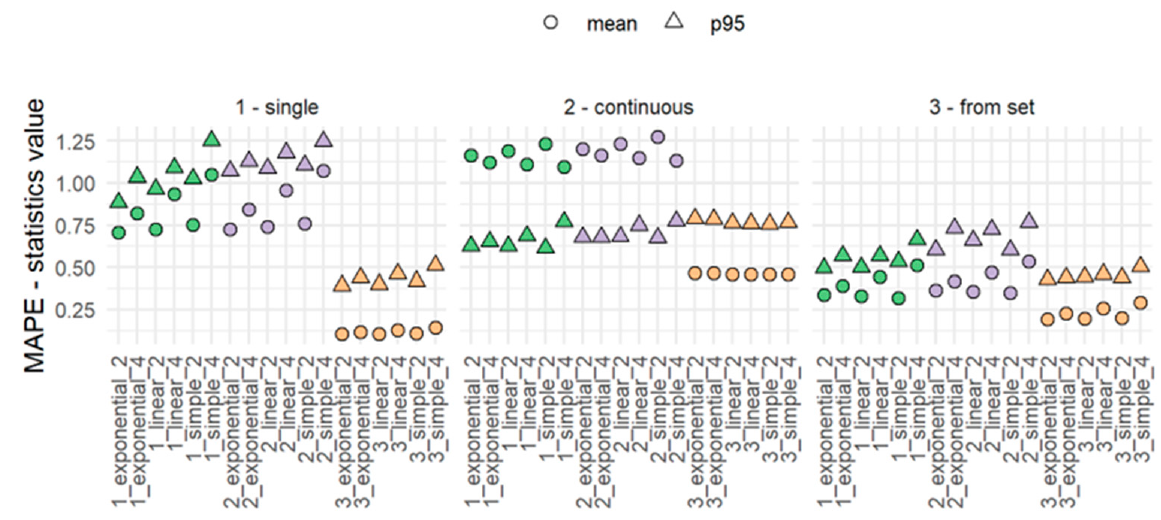
Figure 7. MAPE—mean and quantile 95 for sets and methods. Source: own elaboration.